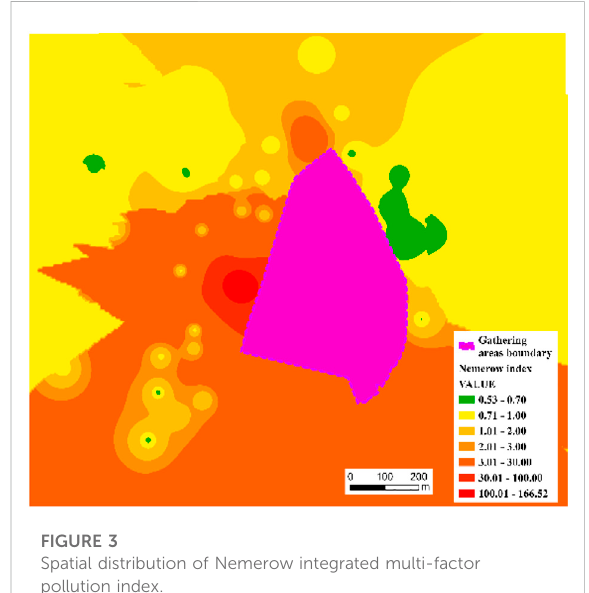
FIGURE 3 Spatial distribution of Nemerow integrated multi-factor pollution index.